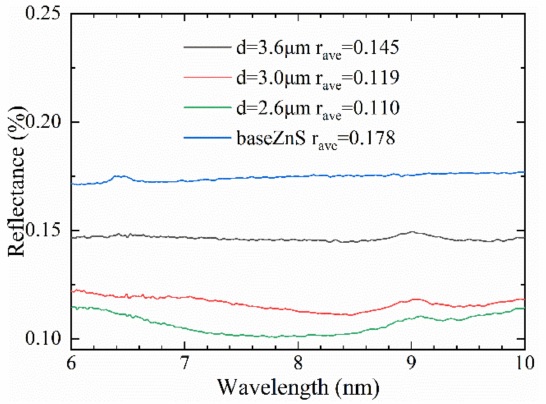
Figure 7. IR reflectance of the ZnS before and after ablating microhole array.